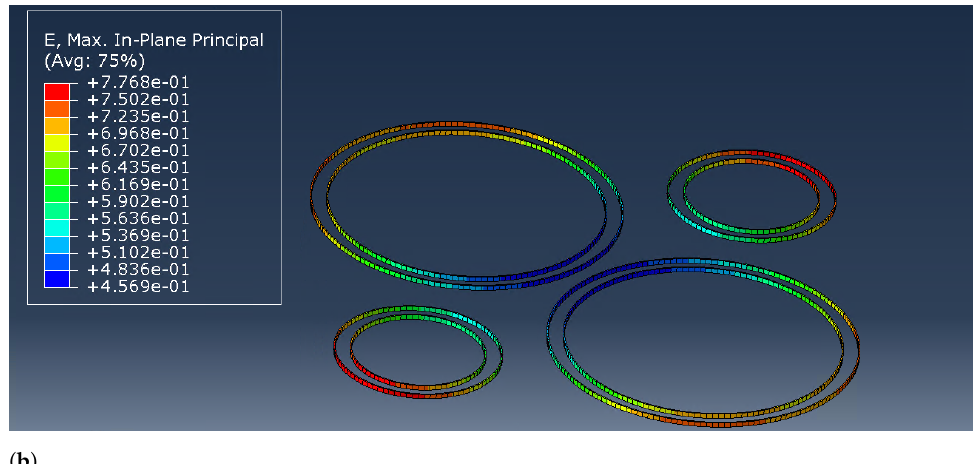
Figure 15. Finite-element analysis of sealing deformation distribution on hub-and-clamp design. ( a ) Distribution of sealing deformation with convex flange. ( b ) Distribution of sealing deformation with flat